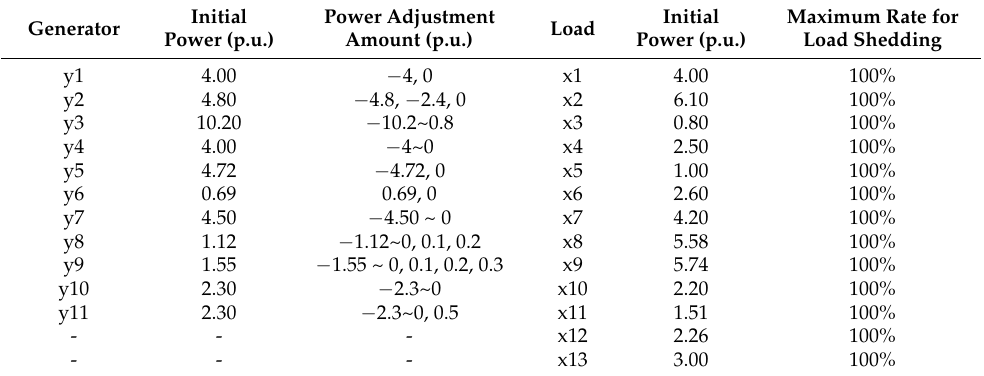
Table 8. Initial and adjustable active power of generators and loads in the regional power system. Initial Power Adjustment Generator Power (p.u.) Amount (p.u.)